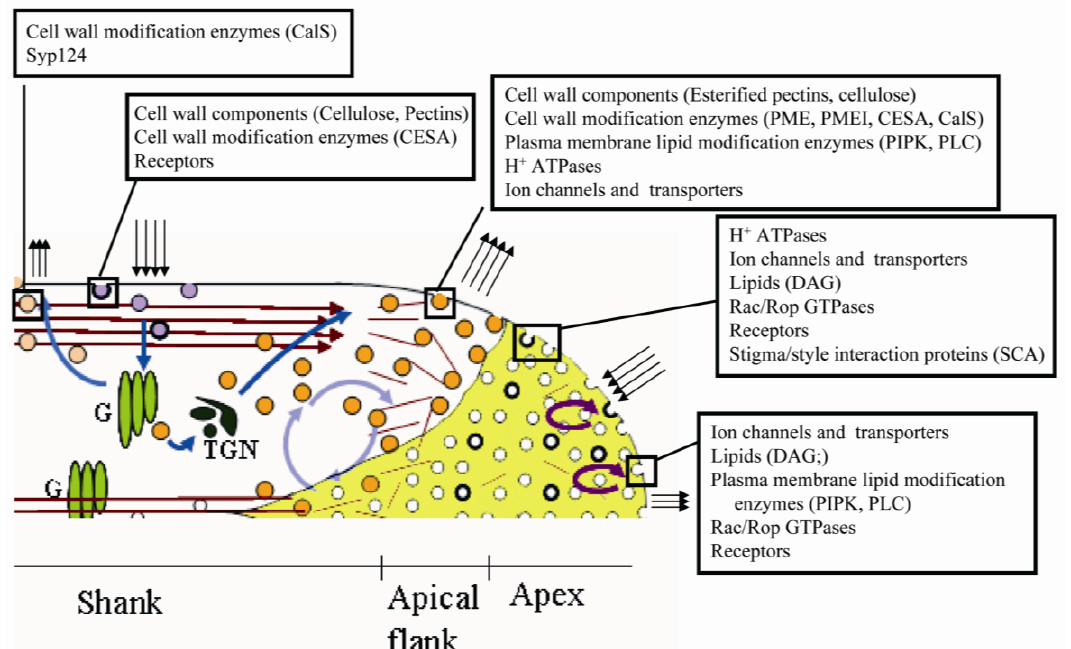
Figure 2. Exocytic/endocytic pathways of molecules involved in pollen tube growth.